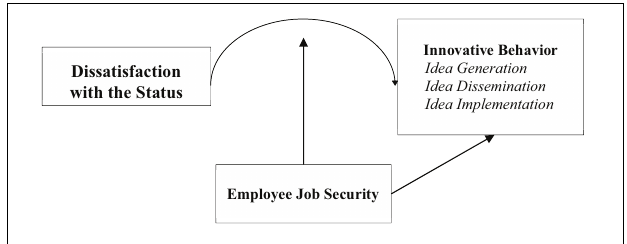
FIGURE 1 | Research